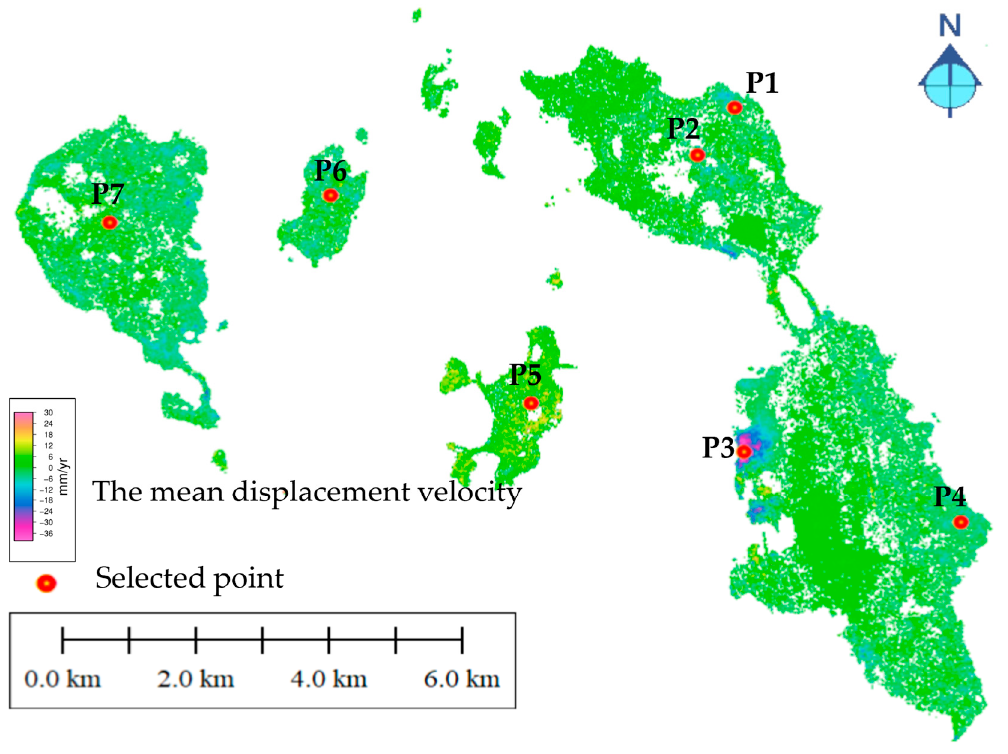
Figure 10. Sketch map of 9 selected points.